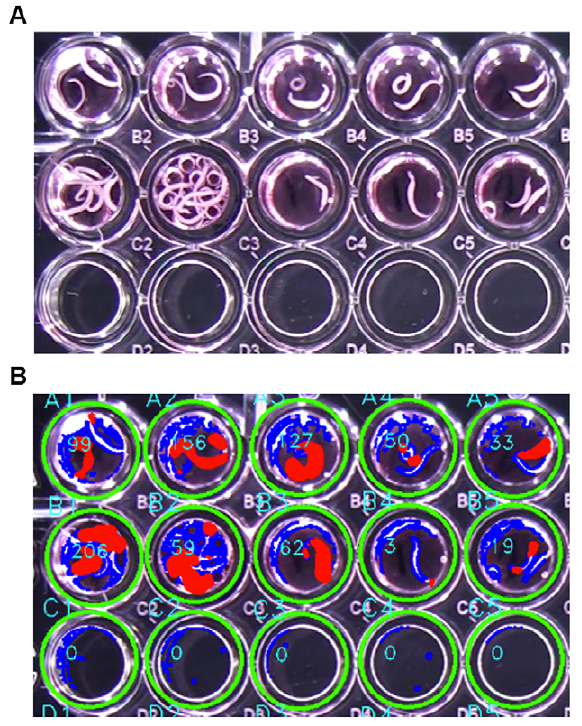
Figure 5. Schistosomamansoni adult worms can also be assayed in 24- or 96-well plates using the WormAssay visual imaging system. (A) Unprocessed video frame in a 96-well plate. (B) Screen capture of the software’s user interface for those plates using the Consensus Voting Luminance Difference algorithm (see caption for Figure